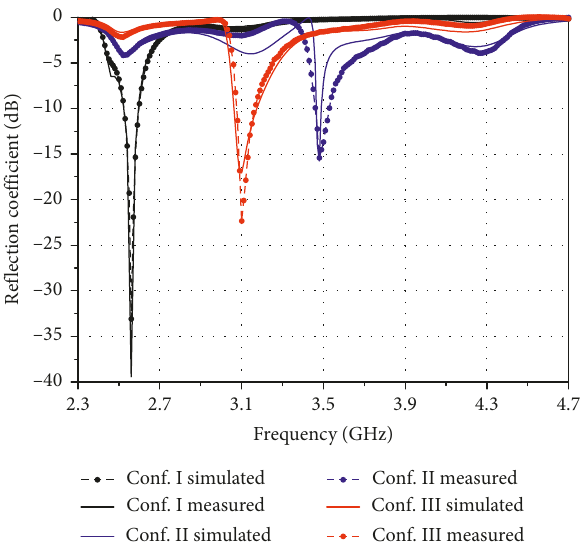
Figure 6: Microwave horn filtenna reflection coefficient. Conf. I ( d ( d 1 � 19.0mm and d 2 � 12.3mm) centered at 3.1GHz; and Conf. III ( d 1 � 13.0mm and d 2 � 13.5mm) centered at 3.5